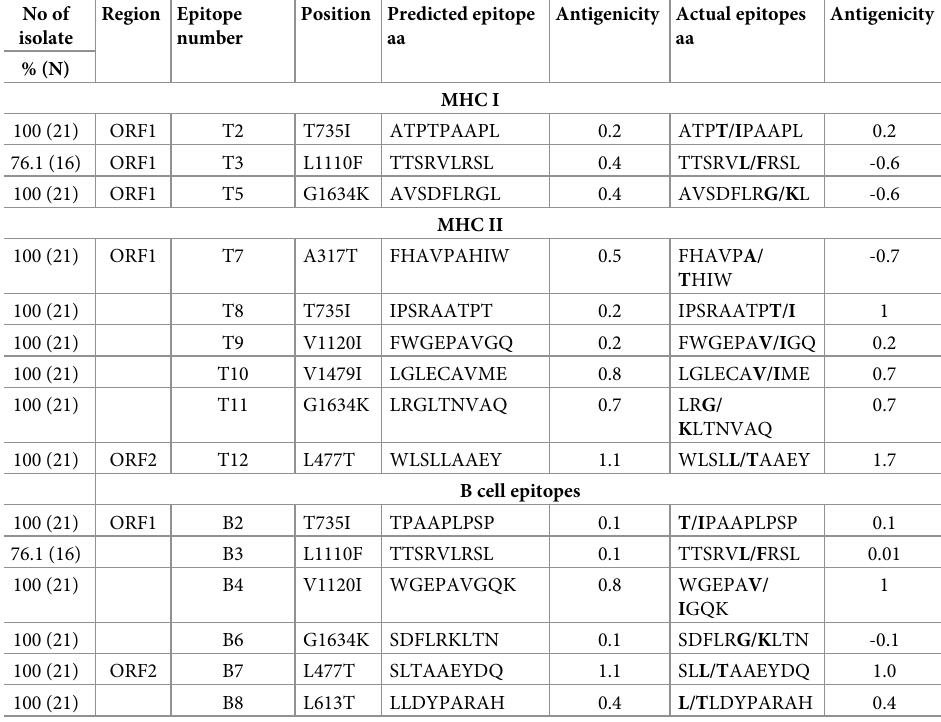
The effect of mutation and antigenicity was adopted from Ikram et al,. Bolt letters indicate mutations in the predicted